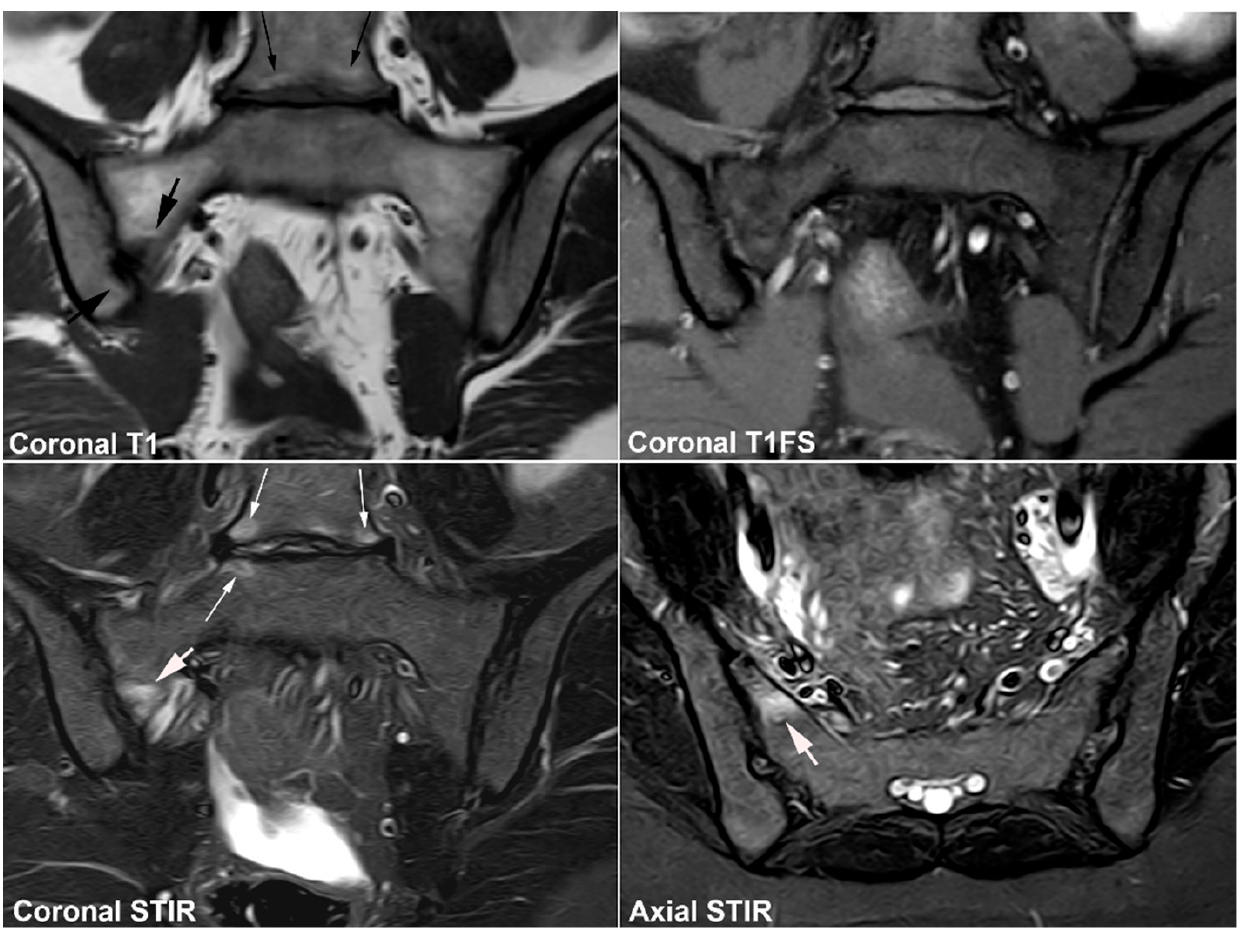
Figure 16. Postpartum BME in a 38-year-old woman complaining of persistent low back pain 12 months after a childbirth, semi-coronal T1, T1FS and STIR, and semi-axial STIR images showing subchondral BME at the anterior portion of the right SIJ (white arrows) with a brim of surrounding fat deposition (black arrows on T1). There are additional disk degenerative changes with subchondral BME and fat deposition (long thin white and black arrows, respectively).